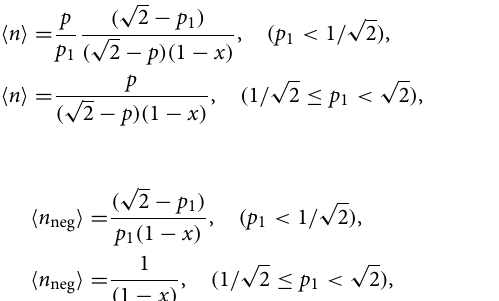
of 3.34 for L Around p